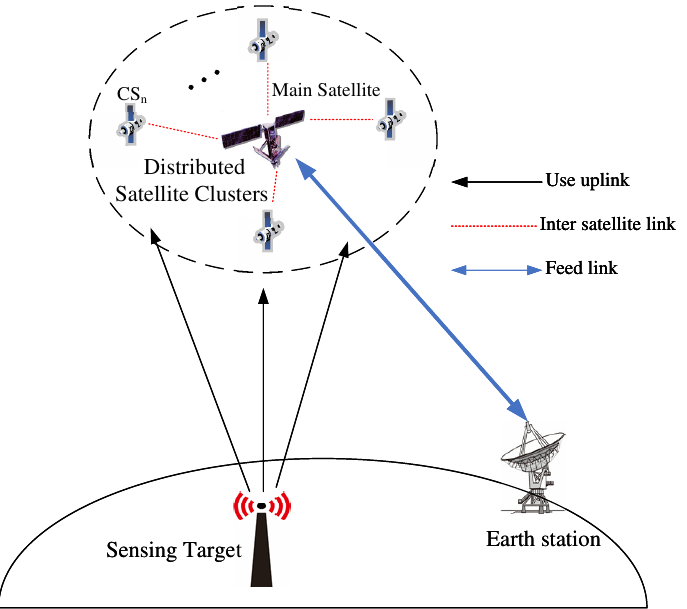
Figure 1. Proposed spectrum-sensing model comprising of a DSC system and a sensing